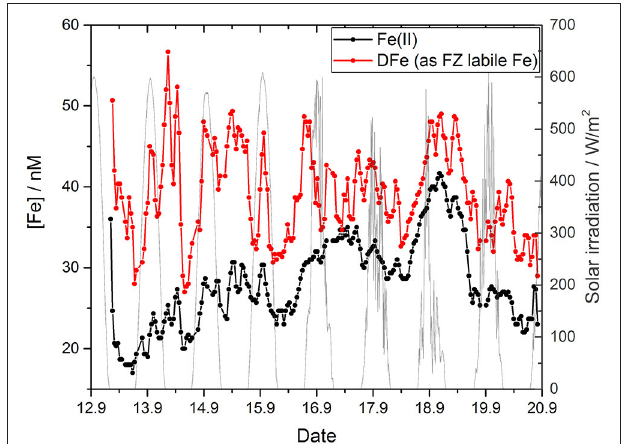
FIGURE 6 | Nine day time series of Fe(II) and DFe (as FZ labile Fe) obtained with the in situ analyzer in Kiel Fjord together with the recorded solar irradiation (gray line) next to the deployment